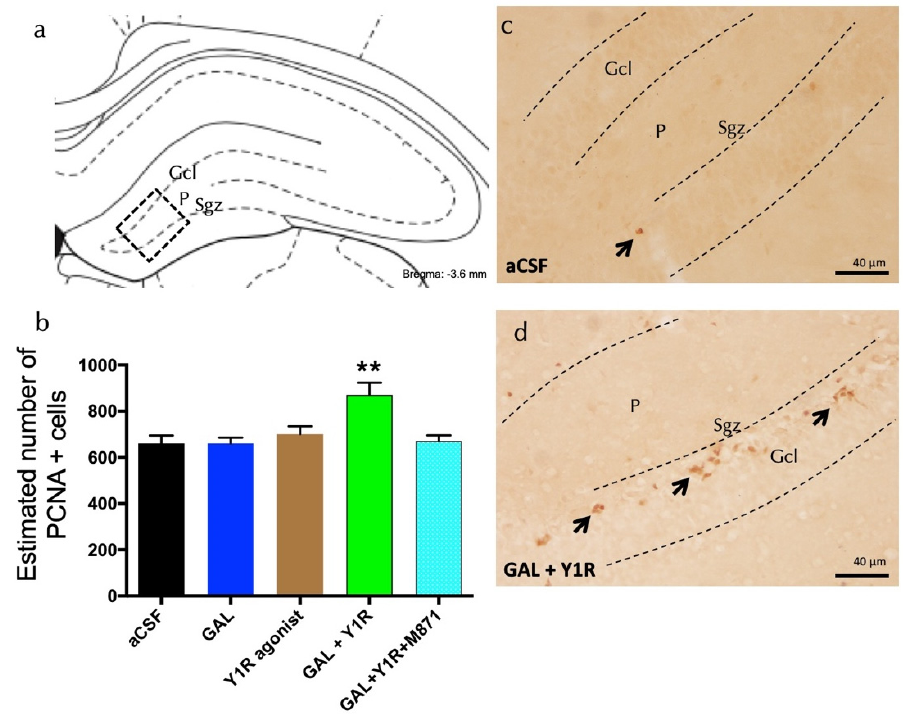
Figure 1. Co-administration of galanin and Y1R agonists increases cell proliferation in the dentate gyrus of adult rats. Proliferating cell nuclear antigen immunolabeling (PCNA+) in the dentate gyrus of the dorsal hippocampus, after the intracerebroventricular (icv) administration of galanin (GAL) and Y1R receptor agonists, either alone or in combination with or without the GAL 2 receptor antagonist (M871). ( a , d ) The majority of the PCNA-IR cells were located in the sub-granular zone (Sgz) of the dentate gyrus at the border between the granular cell layer (Gcl) and the polymorphic layer (P) of the dentate gyrus in the dorsal hippocampus. They appeared as groups of 3–4 cells (Bregma: − 3.6 mm, according to the Paxinos and Watson stereotaxic atlas [33]). ( b ) Quantification of total PCNA-IR cells in the dorsal hippocampal dentate gyrus. Data represent mean ± SEM, showing the differences between groups after the injections of aCSF, GAL, the Y1R agonist [Leu 31 ,Pro 34 ]NPY, or the co-administration of both substances with or without M871. GAL and the Y1R agonist co- administration augmented the number of PCNA+ cells in the dorsal hippocampus compared to the lack of effects of the two peptides alone and the aCSF group. Additionally, this effect was blocked by the GALR2 antagonist M871. ** p < 0.01 vs. the rest of the groups according to one-way ANOVA followed by Newman–Keuls post-hoc test. N = 4 in each group. Statistical values are presented in Supplementary Table S1. GAL and Y1R agonist co-injection ( d ) increased the PCNA-IR cells in Sgz in the dentate gyrus compared with the control group ( c ). Arrows indicate examples of clusters of PCNA+ nerve cells. Dashed lines outline the Gcl of the dentate gyrus. Abbreviations: aCSF = Control (artificial cerebrospinal fluid), GAL = galanin (3 nmol), Y1R agonist = Y1R receptor agonist [Leu 31 , Pro 34 ]NPY (3 nmol), GAL + Y1R = co-administration of GAL and Y1R, GAL + Y1R + M871 = co-administration of GAL, Y1R, and GALR2 antagonist M871 (3